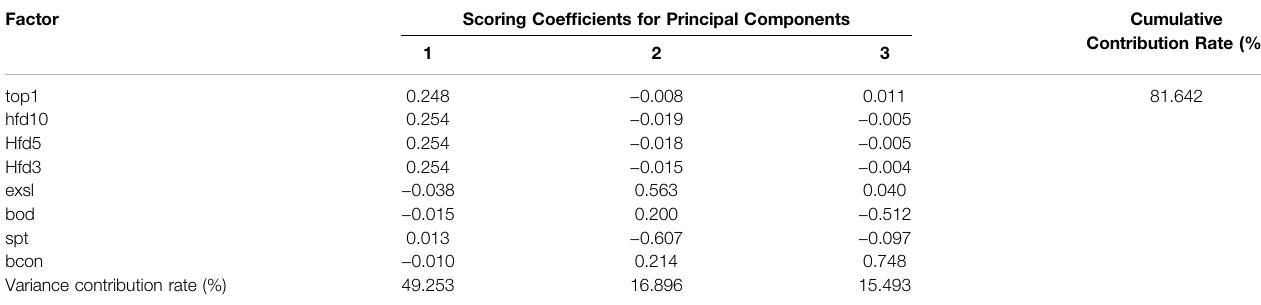
TABLE 4 | Measures of corporate governance level. Factor